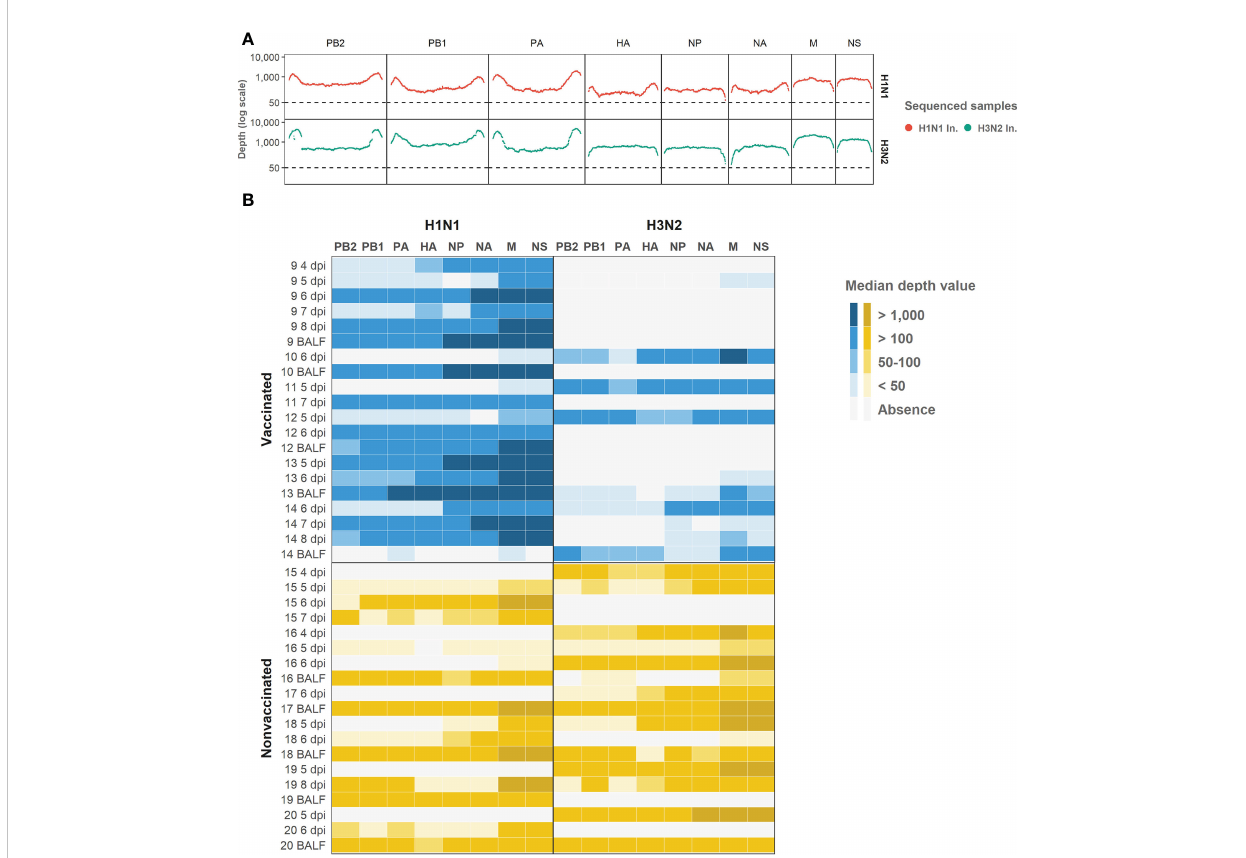
FIGURE 4 Illumina sequencing reads aligned against each subtype genomic pro fi le. (A) Illumina sequencing pro fi le of swine IAV H1N1 (plotted in red) and H3N2 (plotted in green) used as inocula. In the x axis each position per genomic segment is indicated whereas the depth of read is indicated in y axis in the logarithm scale. (B) Heat map of the median depth value obtained in all sequenced samples from vaccinated and nonvaccinated animals per H1N1 (left) and H3N2 (right) genomic segments. Genomic segments per subtype and samples are indicated in the x and y axes, respectively. The name of each sequenced sample indicates the origin and the day of its collection. BALF samples were collected at each pig